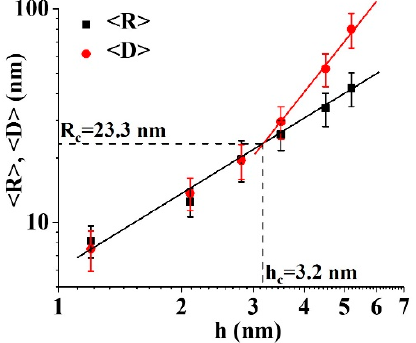
Figure 6. Evolution plot of mean width <R> and mean length <D> of Au/Pd islands versus thickness h of the deposited Au/Pd film, for 1.2 ≤ h ≤ 5.2 nm. Full lines arose by fitting procedures of experiment data.